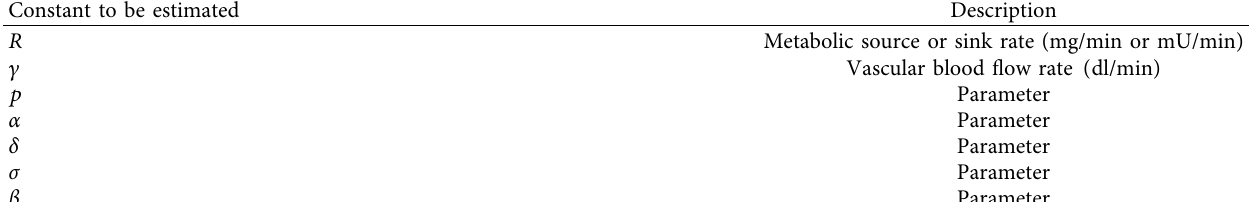
Table 2: Nomenclature of mathematical model parameters to be estimated.